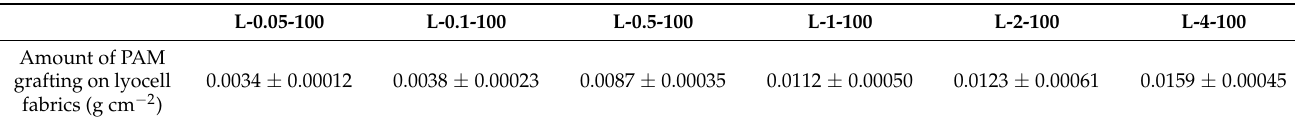
Figure 7. Schematic illustration of the preparation of carbon fabrics from lyocell fabrics grafted with PAM via EBI, stabilization, and carbonization. Table 2. Amount of PAM grafting on lyocell